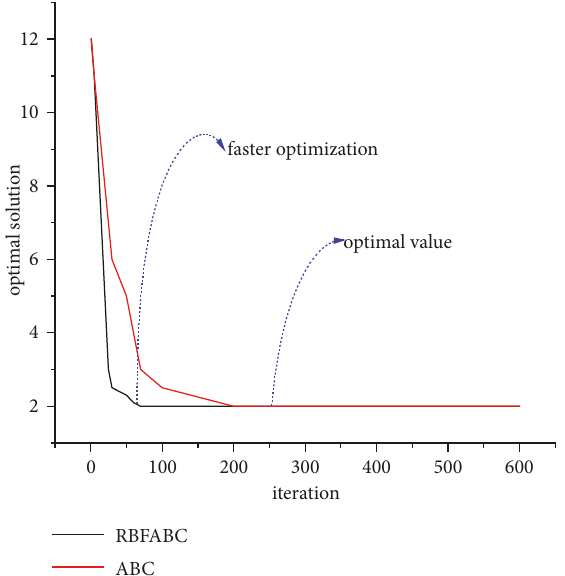
Figure 7: Comparison of network delay.